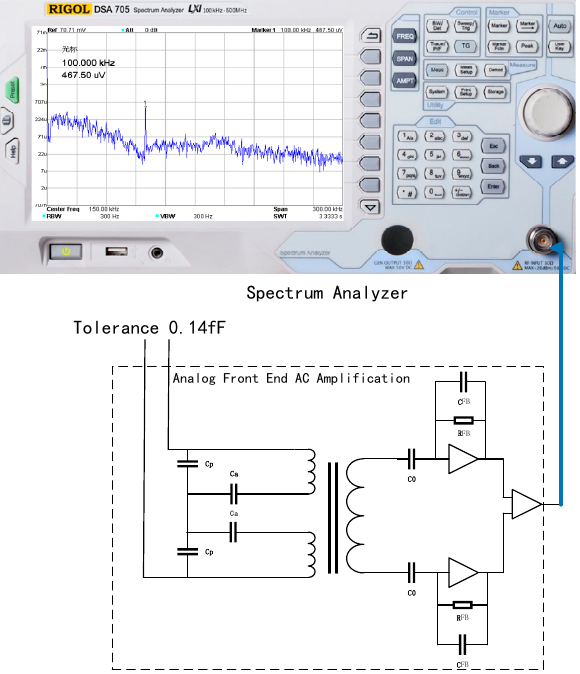
Figure 16. Capacitive sensing system demodulation function module under measurement 0.14 fF tolerance.